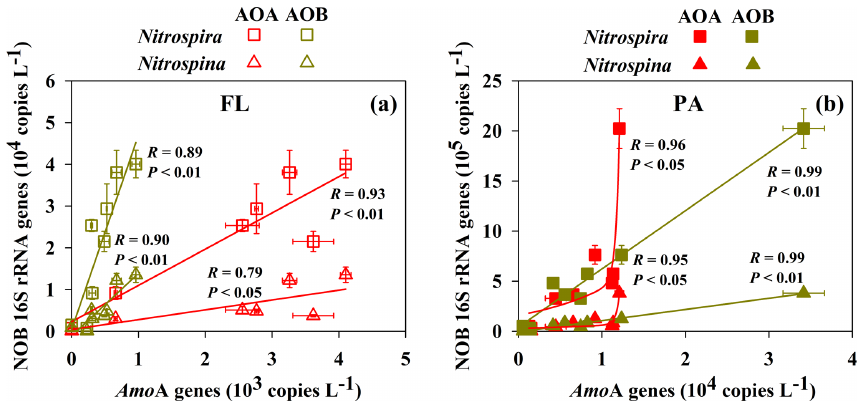
Figure 8. Correlations between ammonia and nitrite oxidizers in the hypoxic zone of the PRE (sites P1–6). There are significant positive correlations ( n = 8) between archaeal and β -proteobacterial amo A genes and Nitrospira and Nitrospina 16S rRNA gene abundances in (a) FL and (b) PA communities. Error bars represent standard deviations.